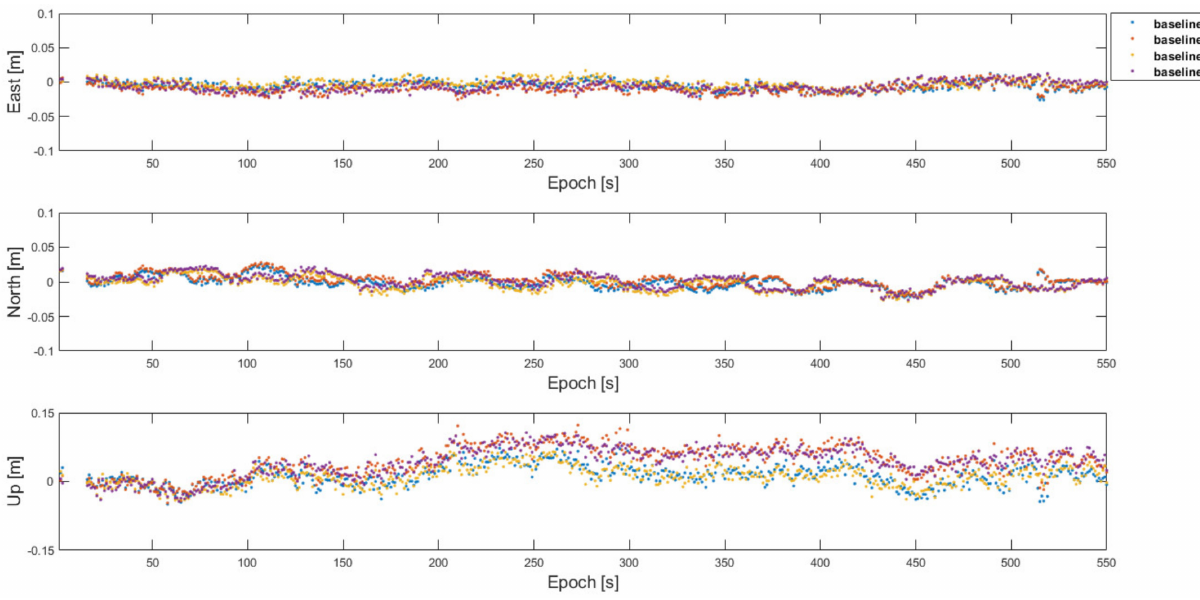
Figure 22. Position errors of the baselines across the cells with the proposed framework using 6 common satellites in view in Figure